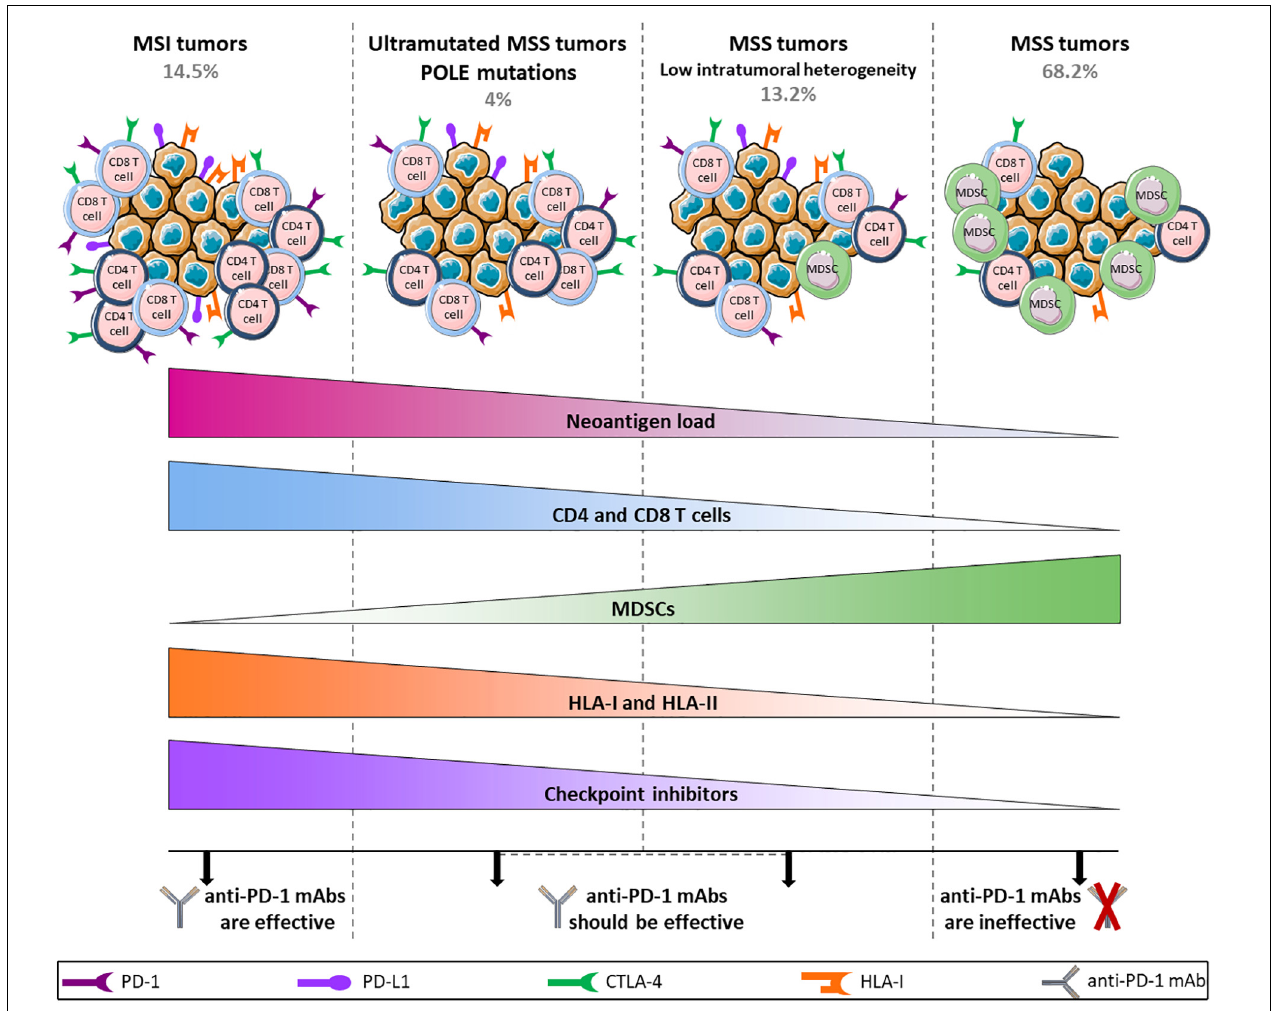
FIGURE 2 | Hypothetical model of anti-PD-1 mAbs efficacy/inefficacy according to different subtypes of CRC tumors. MSI and ultramutated MSS tumors show high neoantigen load associated with a large infiltration of CD4 and CD8 T cells and an upregulation of immune inhibitory receptors, allowing the use of anti-PD-1 mAbs. In contrast, tumor escape mechanisms in MSS tumors rely on a downregulation of HLA class-I and class-II along with a high infiltration of MDSCs, and the level of T cells remains low. In addition, the weak expression of inhibitory receptors in these tumors does not allow the use of anti-PD-1 mAbs, apart from a restricted group of MSS tumors characterized by low intratumoral heterogeneity that shares several features with mutated tumors and that should be able to respond to anti-PD-1